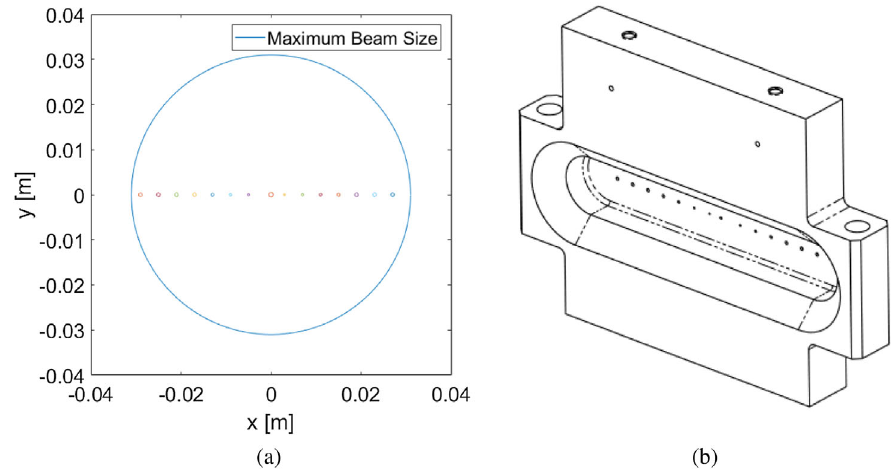
FIG. 2. (a) Schematic of relative hole sizes and location (b) Mechanical drawing of the